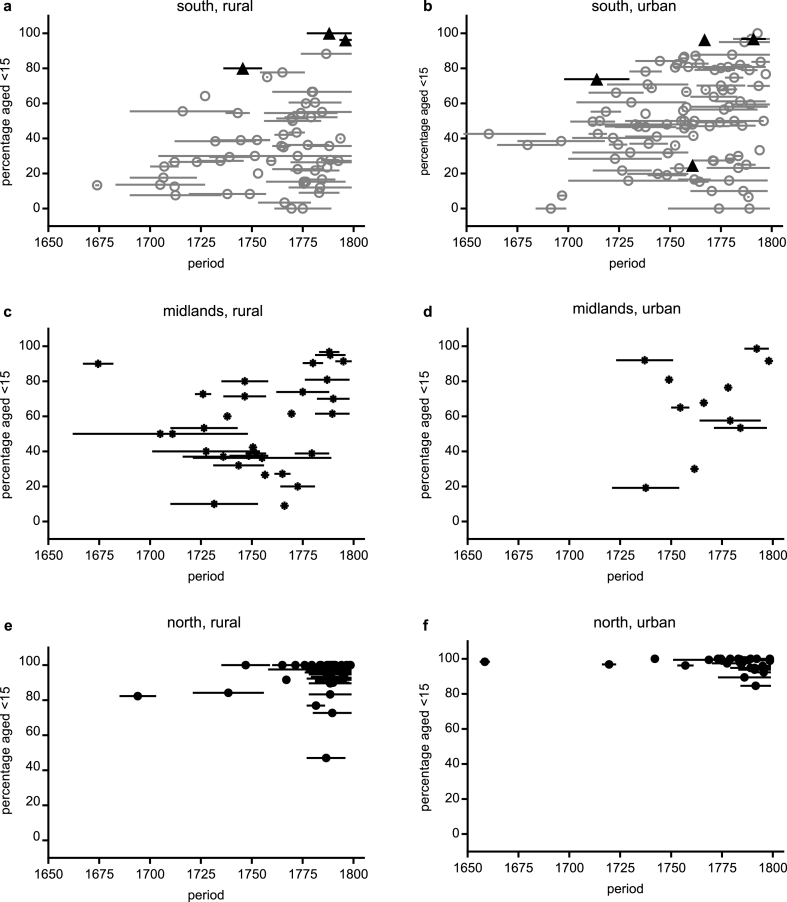
Percentage of smallpox burials aged under 15 or child by period, rural/urban and region of England. Triangles represent places in Cornwall.